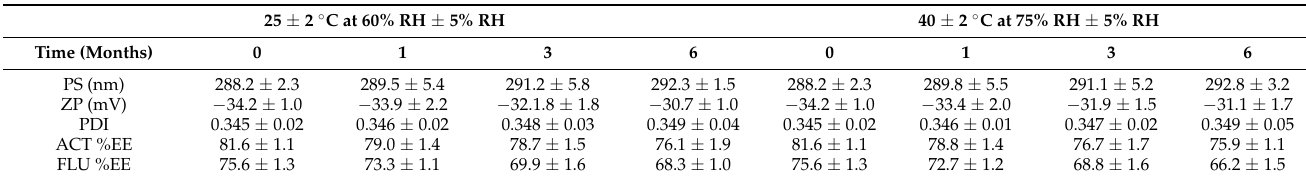
Table 5. Stability study of optimized FLU–ACT-coloaded